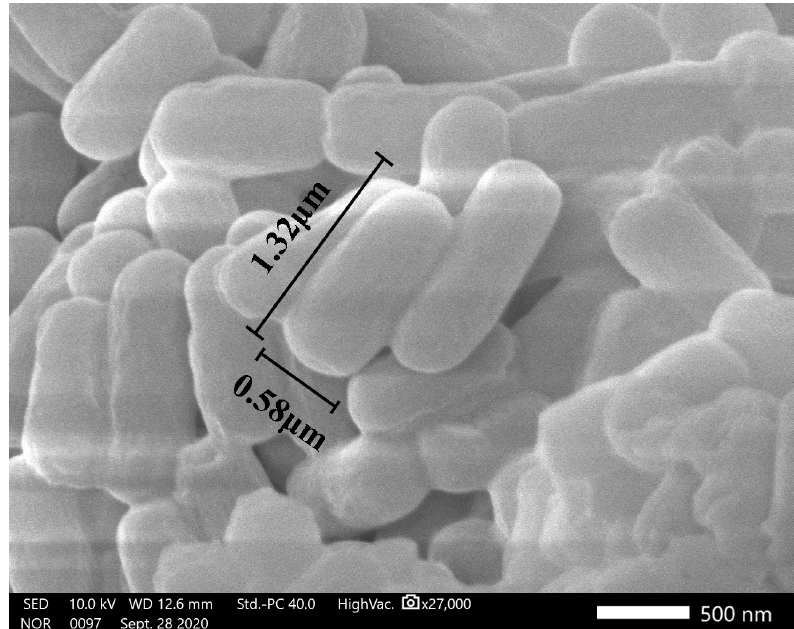
Figure 3. S. pasteurii morphology under SEM.